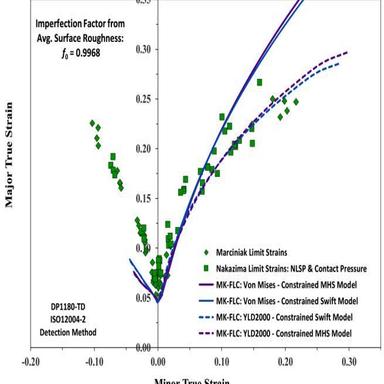
Comparison of MK-predicted FLCs in the transverse direction of DP1180 using different yield functions and the constrained hardening models with the imperfection factor taken from surface roughness measurements.